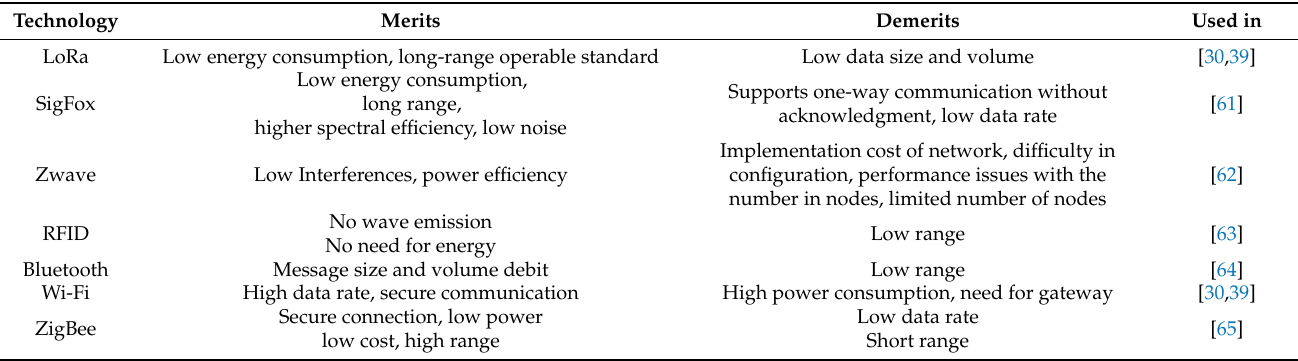
Table 1. Different IoT technologies in vital data acquisition